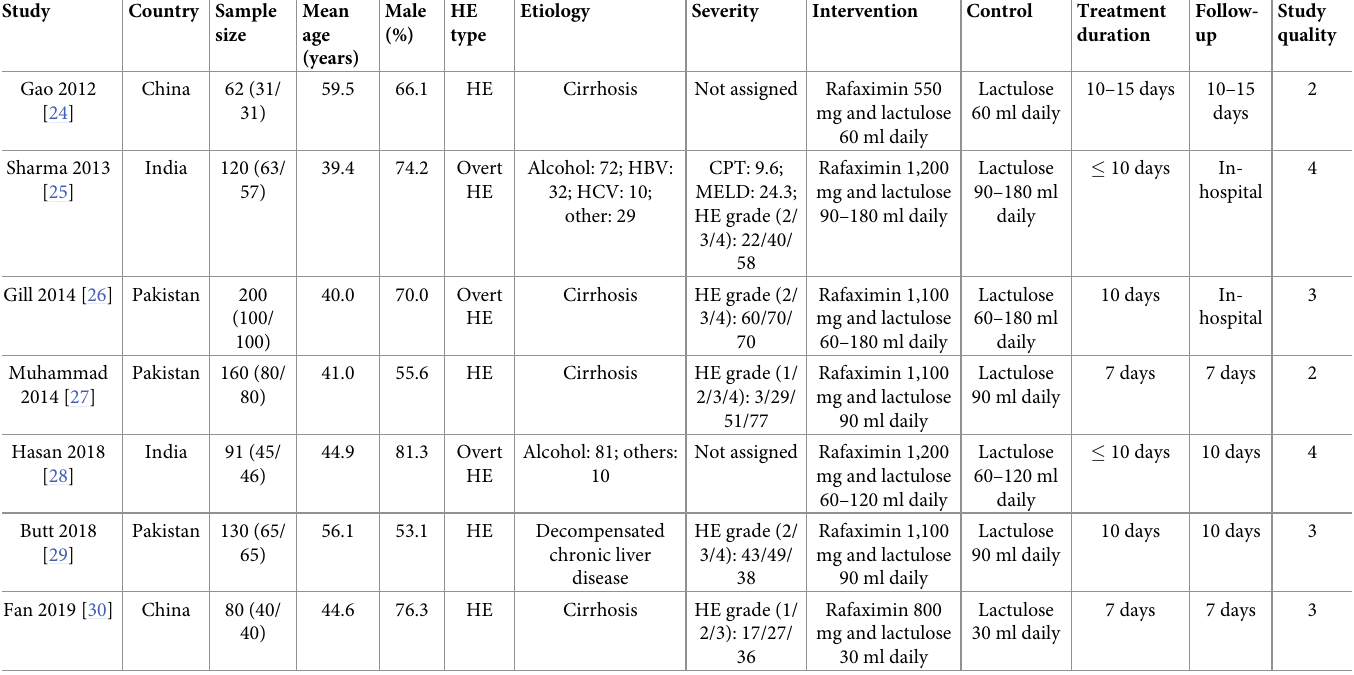
Table 1. The baseline characteristics of included studies and patients.